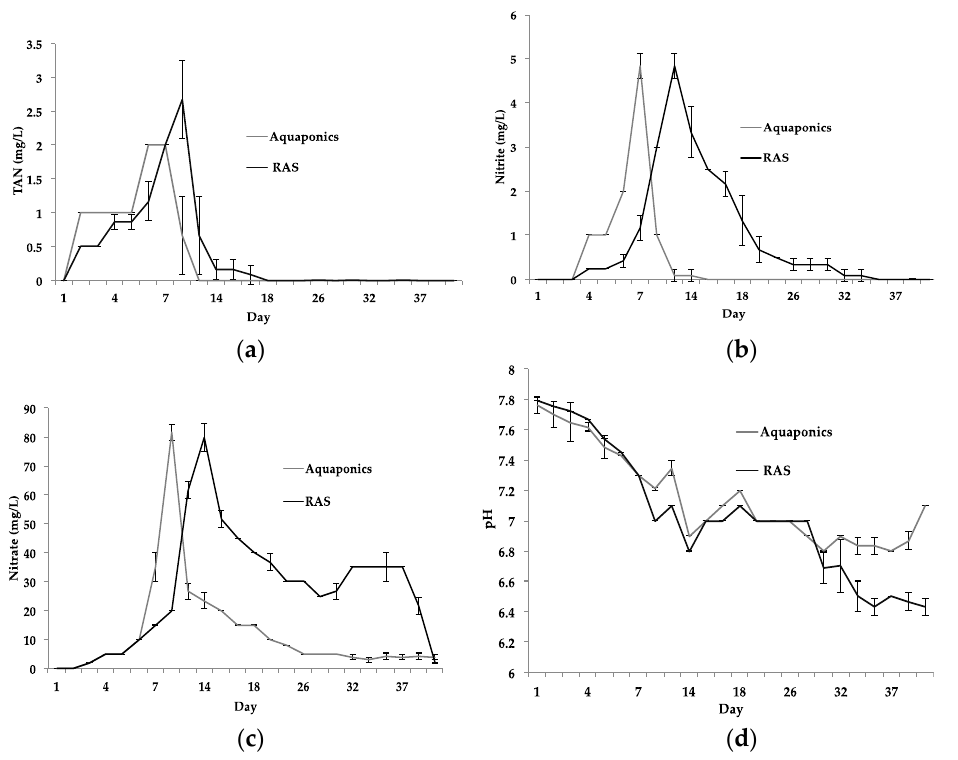
Figure 1. The mean concentration (mg/L) ± SD ( n = 3) of ( a ) total ammonium nitrogen (TAN) ( b ) nitrite, ( c ) nitrate, and ( d ) pH in RAS and aquaponics treatments during the 42-day experiment. For the aquaponics treatment spinach was grown in a coupled aquaponics system together with rainbow trout ( Oncorhynchus mykiss ).